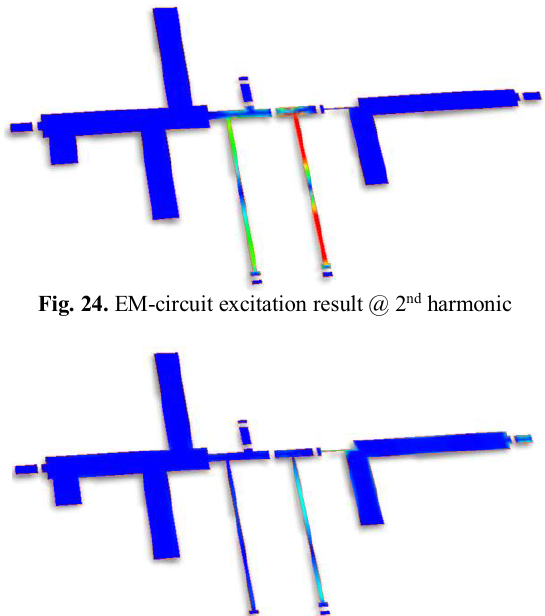
Fig. 25. EM-circuit excitation result @ 3 rd